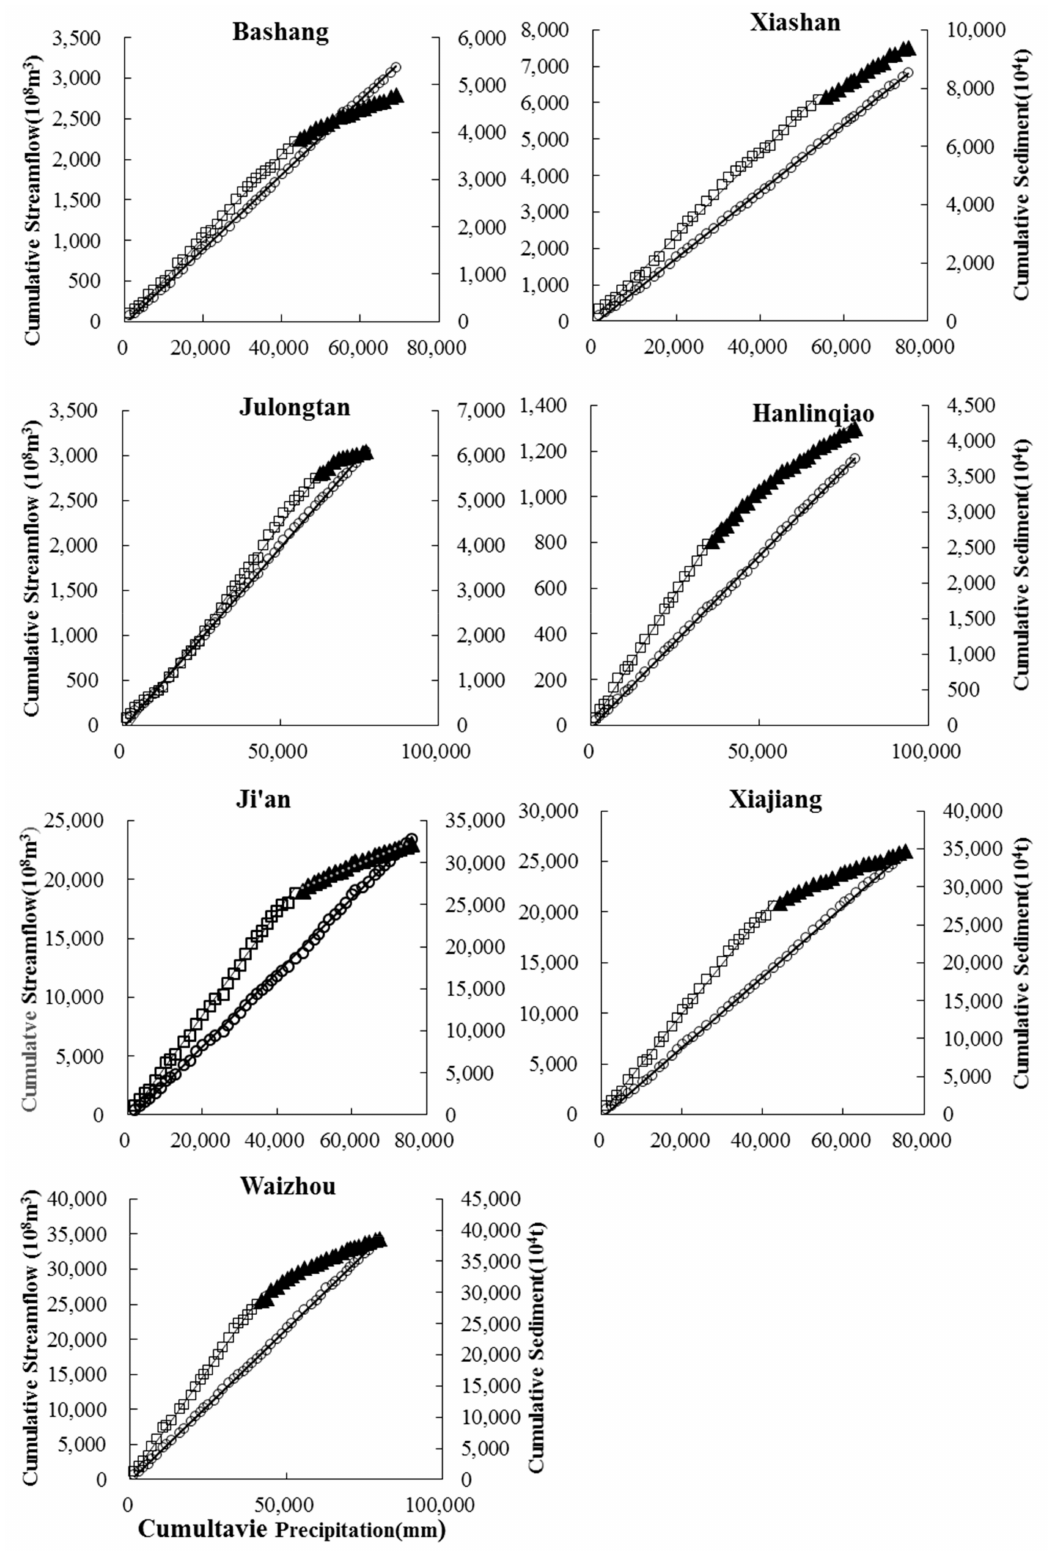
Figure 4. Double mass curves of precipitation–streamflow and precipitation–sediment at seven hydrological stations with sediment data in the Ganjiang River basin. Note: Here, cumulative precipitation–streamflow, (cid:3) and (cid:78) represents cumulative precipitation–sediment before and after the transition year,